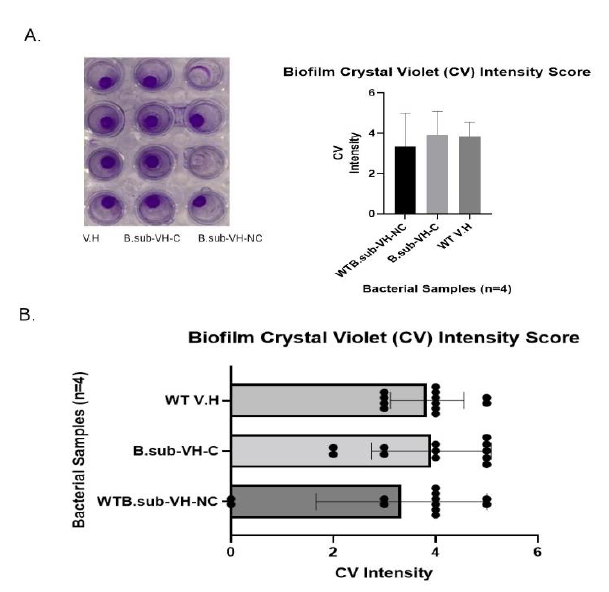
Figure 2 : Biofilm Assay. A. The crystal violet stain of B. subtilis-Carrier-V.H appeared with the highest intensity. B. subtilis-Carrier-V.H and V.H showed a higher score of CV intensity than the WT-B. subtilis-V.H co-cultures. B. The biofilm assays were performed in triplicates, in which the B. subtilis-Carrier-V.H had the highest expression of CV absorbance intensity. B. subtilis-Carrier-V.H co-cultures showed a higher intensity of Crystal Violet absorbance versus the wild type B. subtilis as shown in the simulation of data and in the scatter